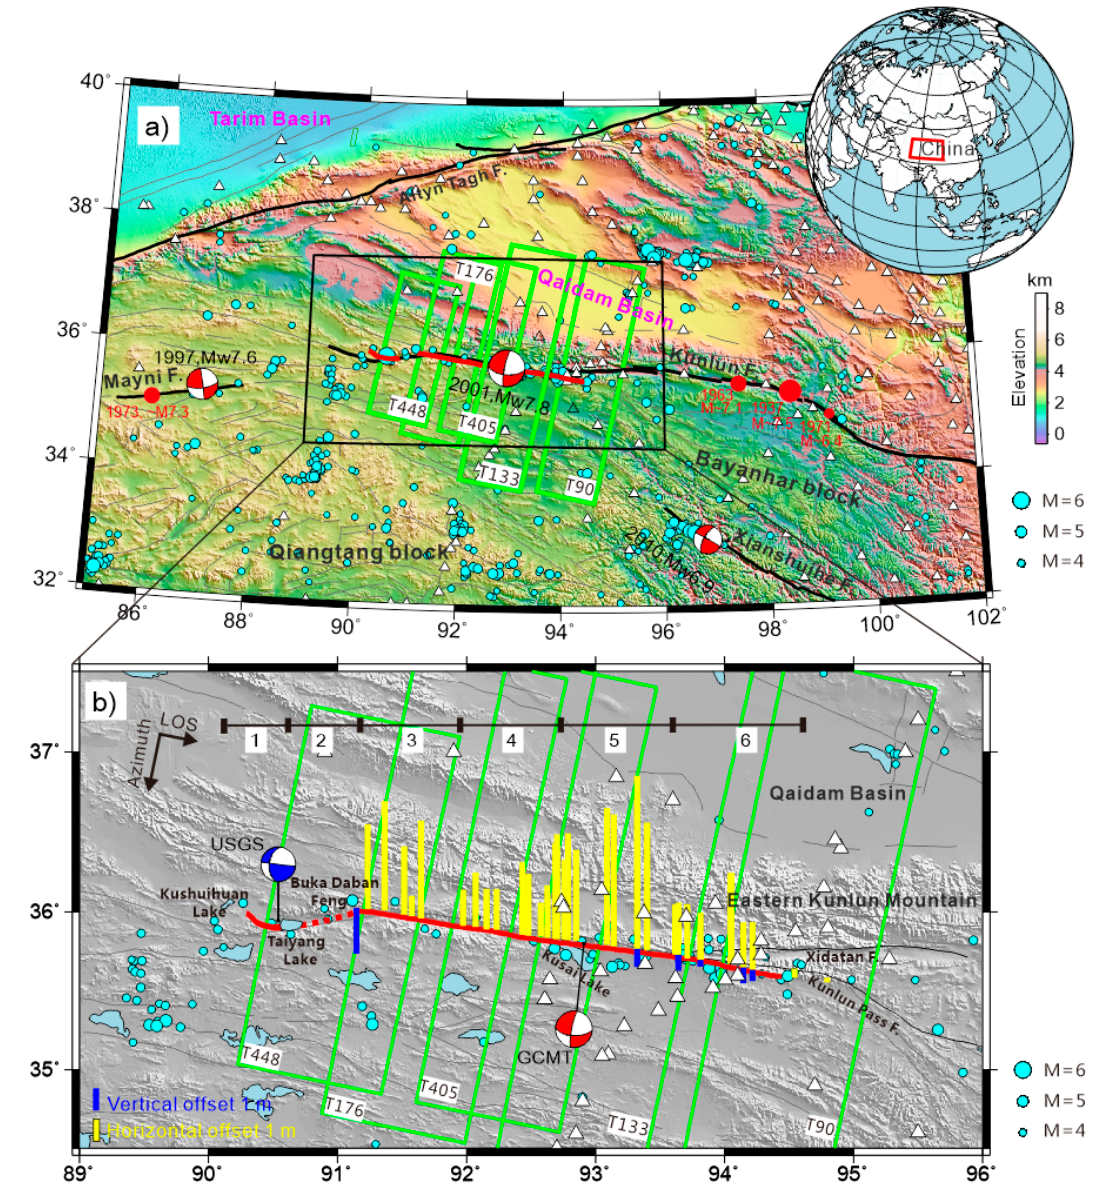
Figure 1. ( a ) Tectonic map of the central Tibetan Plateau showing the main active faults (bold black lines, modified from Tapponnier et al. [27]). Cyan dots indicate the seismicity (M > 4) between 2001 and 2011 from USGS (https://earthquake.usgs.gov). T448, T405, T176, T133 and T90 refer to the five descending Envisat/ASAR tracks used in our study, marked by green boxes. The Global Centroid Moment Tensor (GCMT) focal mechanisms of the 1997 Mw7.6 Manyi, 2001 Mw7.8 Kokoxili and 2010 Mw6.9 Yushu earthquakes are shown. Surface ruptures of the Kokoxili earthquake from field investigation are shown by red lines, modified from Xu et al. [10] and Chen et al. [28]. Grey lines indicate the active faults [29]; ( b ) Detailed map of horizontal (yellow bars) and vertical offsets (blue bars) and surface ruptures (red lines) from field studies of the 2001 Kokoxili earthquake. The six segments of the surface rupture are delimited by black blod lines: 1 (western section), 2 (extensional corridor), 3 (Bukadaban Peek section), 4 (western Kusai section), 5 (eastern Kusai section), 6 (Kunlun Pass section). The focal mechanisms of the 2001 Kokoxili earthquake from USGS and GCMT are presented in blue and red at their hypocenter and moment centroid locations, respectively. The white triangles in ( a , b ) represent the GPS stations operated by the Crustal Motion Observation Network of China [25,30]. The black arrows indicate azimuth and line-of-sight (LOS) directions of descending Envisat tracks.